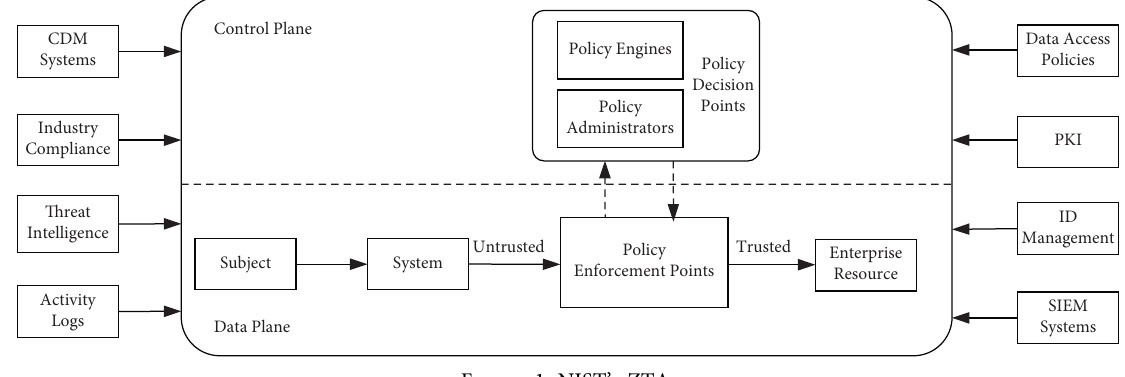
Figure 1: NIST’s